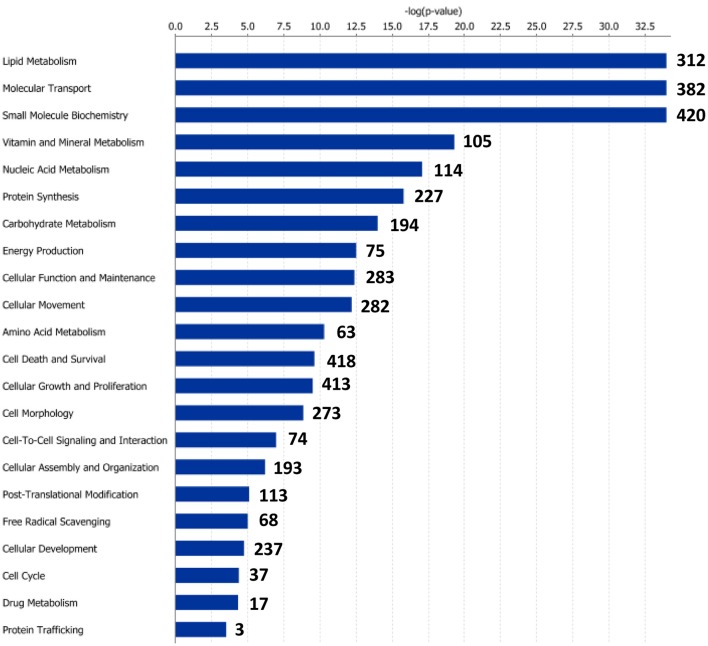
Molecular and cellular functions of differentially expressed genes in the anterior-middle intestine segment (AI-MI). For a given molecular function, blue bars indicate the −log of the P-value, and the number of differentially expressed genes is represented.